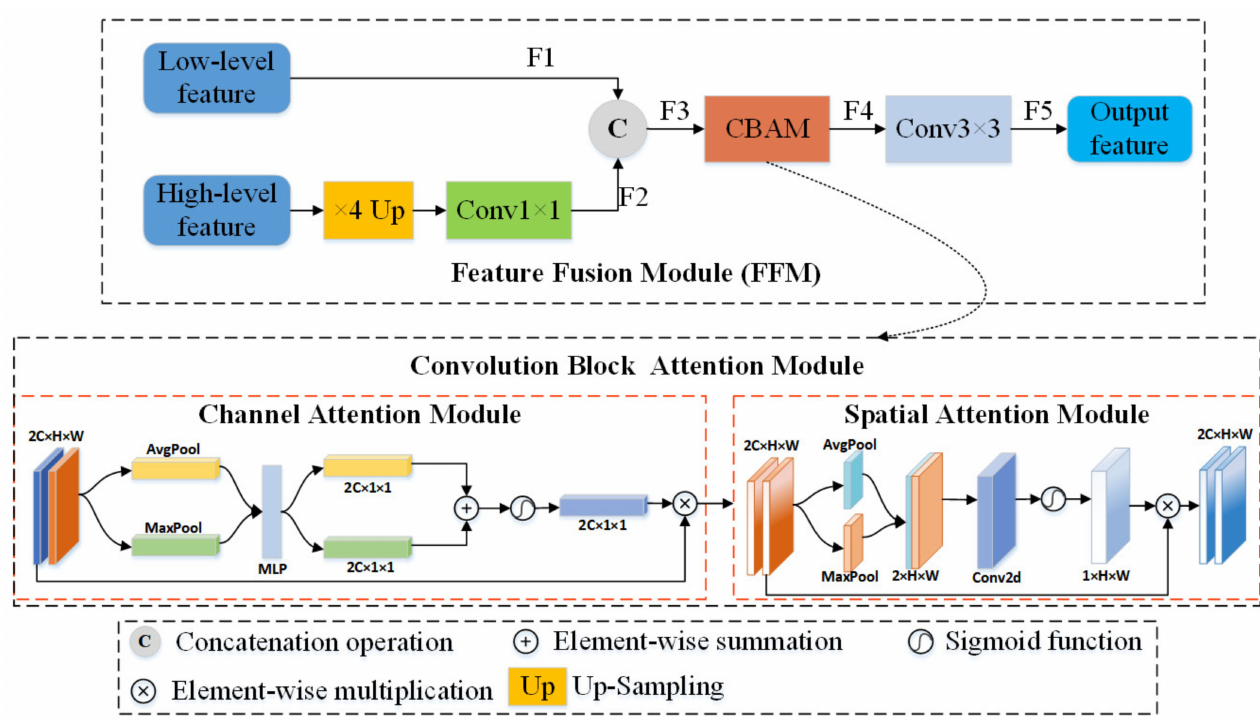
Figure 3. Feature Fusion Module (FFM). F 1– F 5 represent the feature maps that are output by different